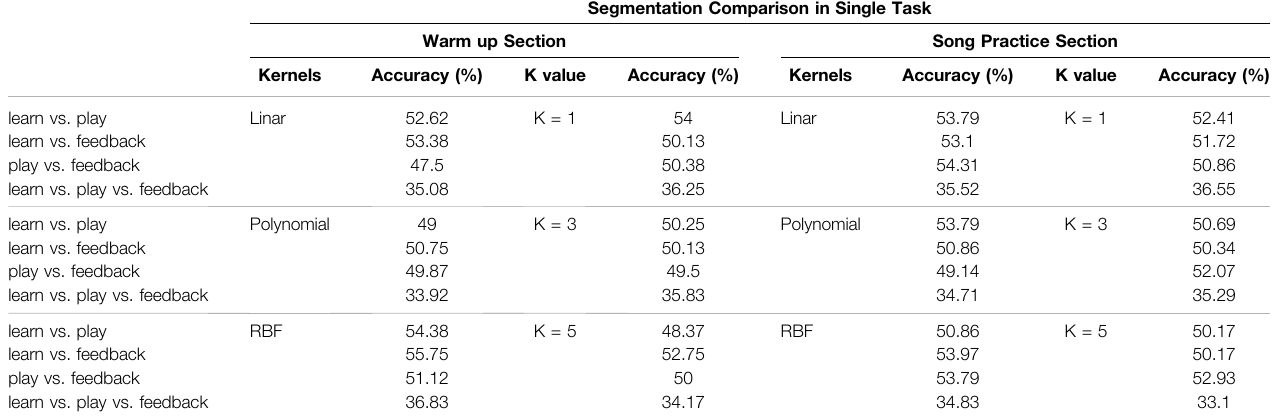
TABLE 2 | Emotion change classi fi cation performance in single event with segmentation using both SVM and KNN classi fi er. Segmentation Comparison in Single